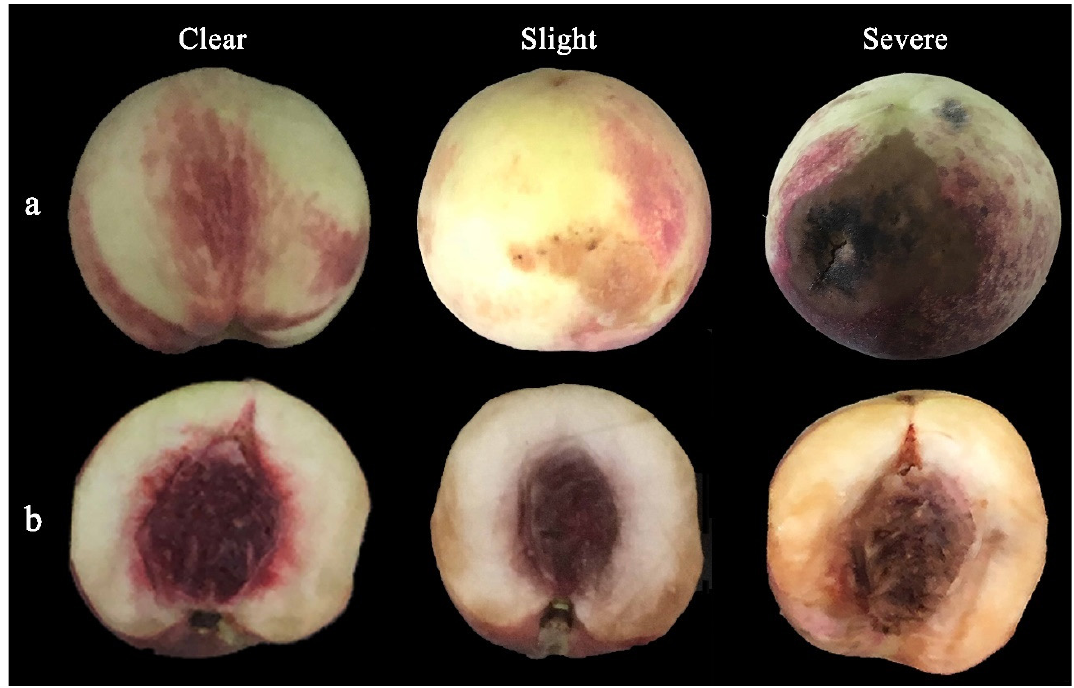
Figure 2. Appearance ( a ) and cut longitudinally ( b ) to assess for good fruit, flesh browning and rotten fruits (From left to right).